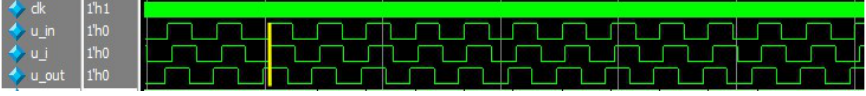
Figure 11. Simulation waveform of frequency-tracking control experiment.